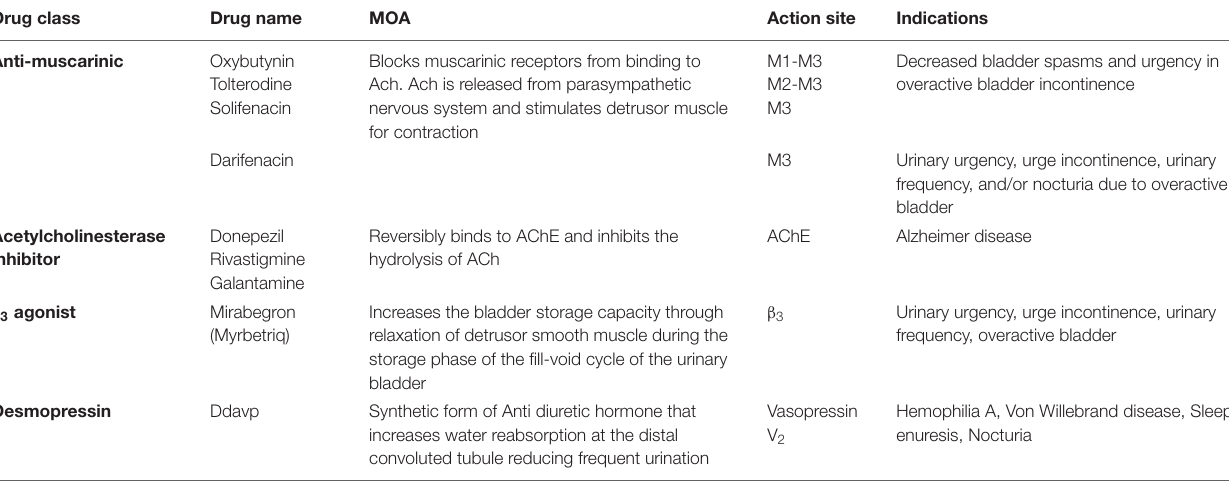
TABLE 1 | Potential drug treatments of Alzheimer’s disease and urinary incontinence. Drug